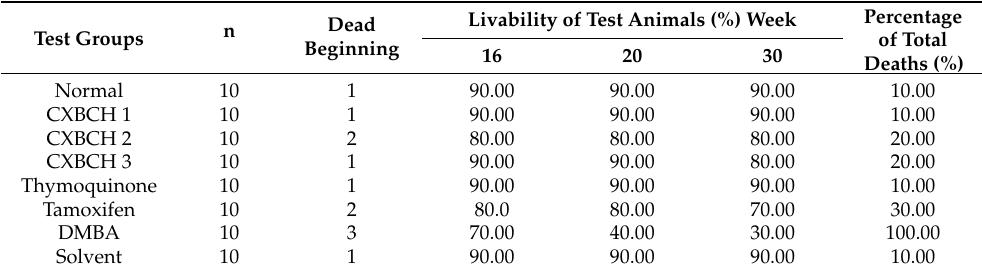
Table 1. Results of observations of the survival ability of each group of SD rats receiving CXBCH two weeks before and five weeks during DMBA